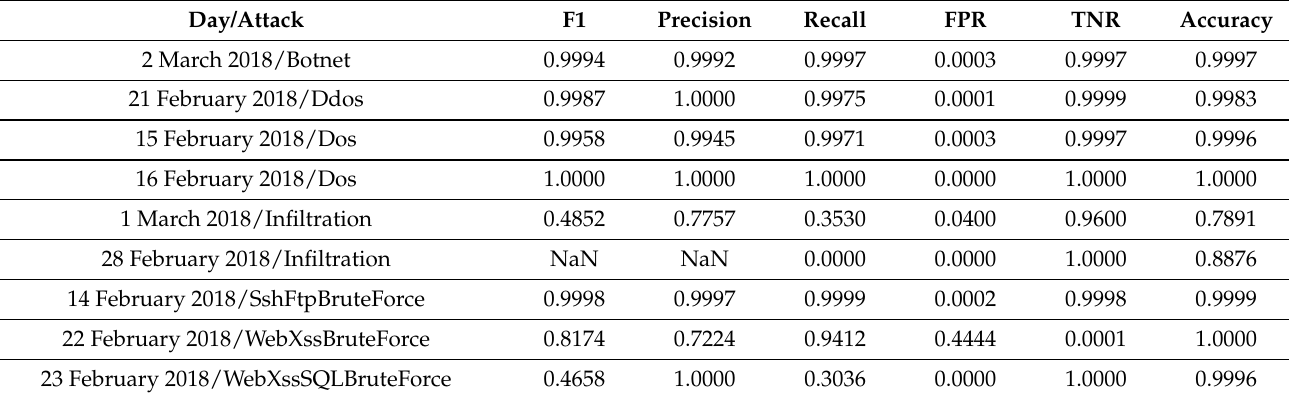
Table 10. Results obtained with a training LSTM and